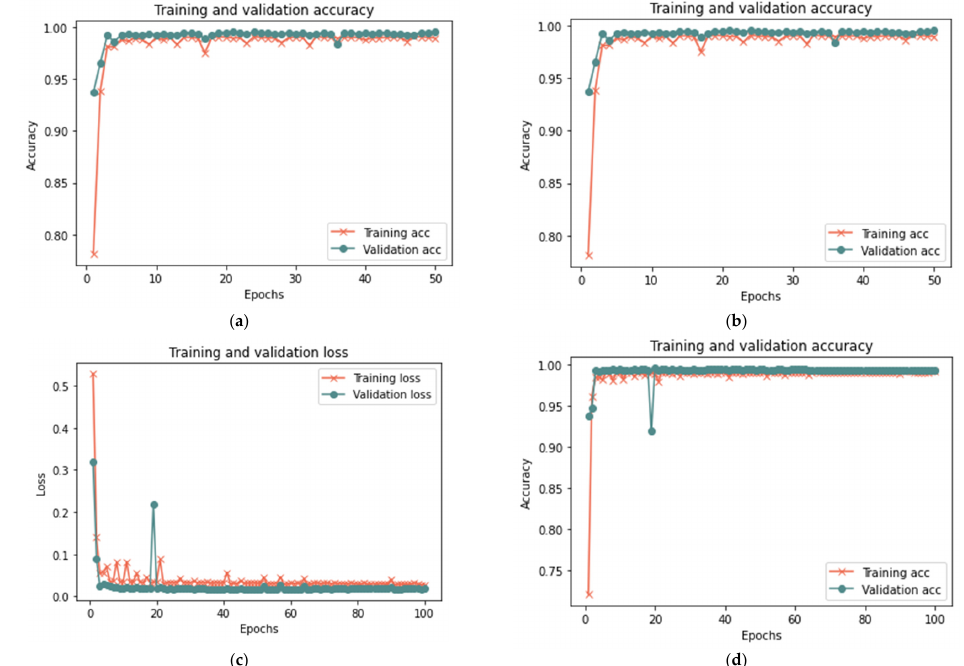
Figure 16. Results of the third scenario with 25% sample size: ( a ) loss at 50 iterations; ( b ) accuracy at 50 iterations; ( c ) loss at 100 iterations; and ( d ) accuracy at 100 iterations.